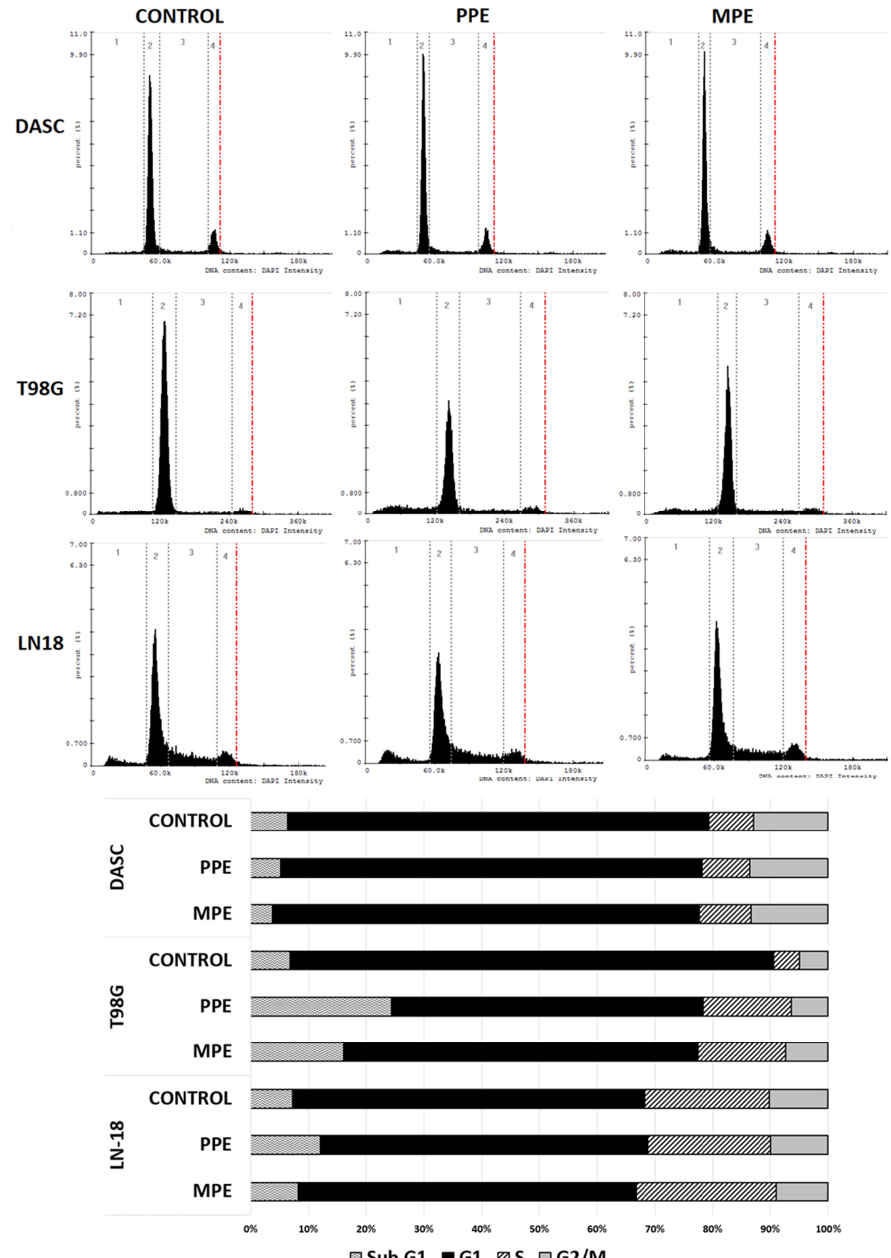
Figure 4. The effect of PPE and MPE on cell cycle analysis. DASC, T98G and LN-18 cells were incubated for 48 h with PPE (30 µ g/mL) and MPE (30 µ g/mL). Both the histogram and the bars present distributions of cells in subG1, G1, S and G2/M phases of the cell